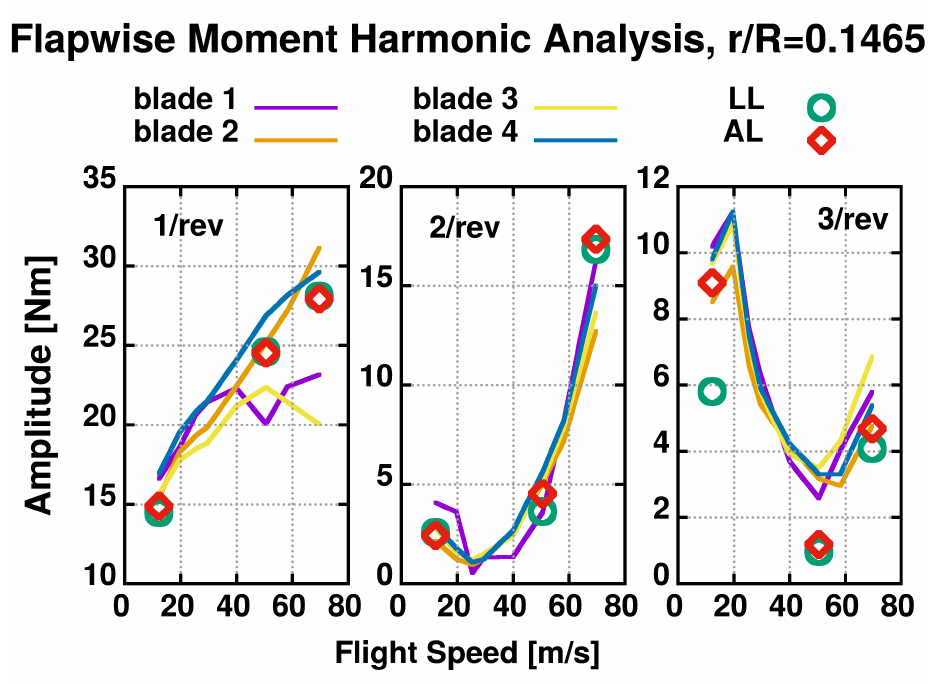
Figure 44. Harmonic analysis of Flapwise bending moment. Amplitude of frequencies with the highest energy content.